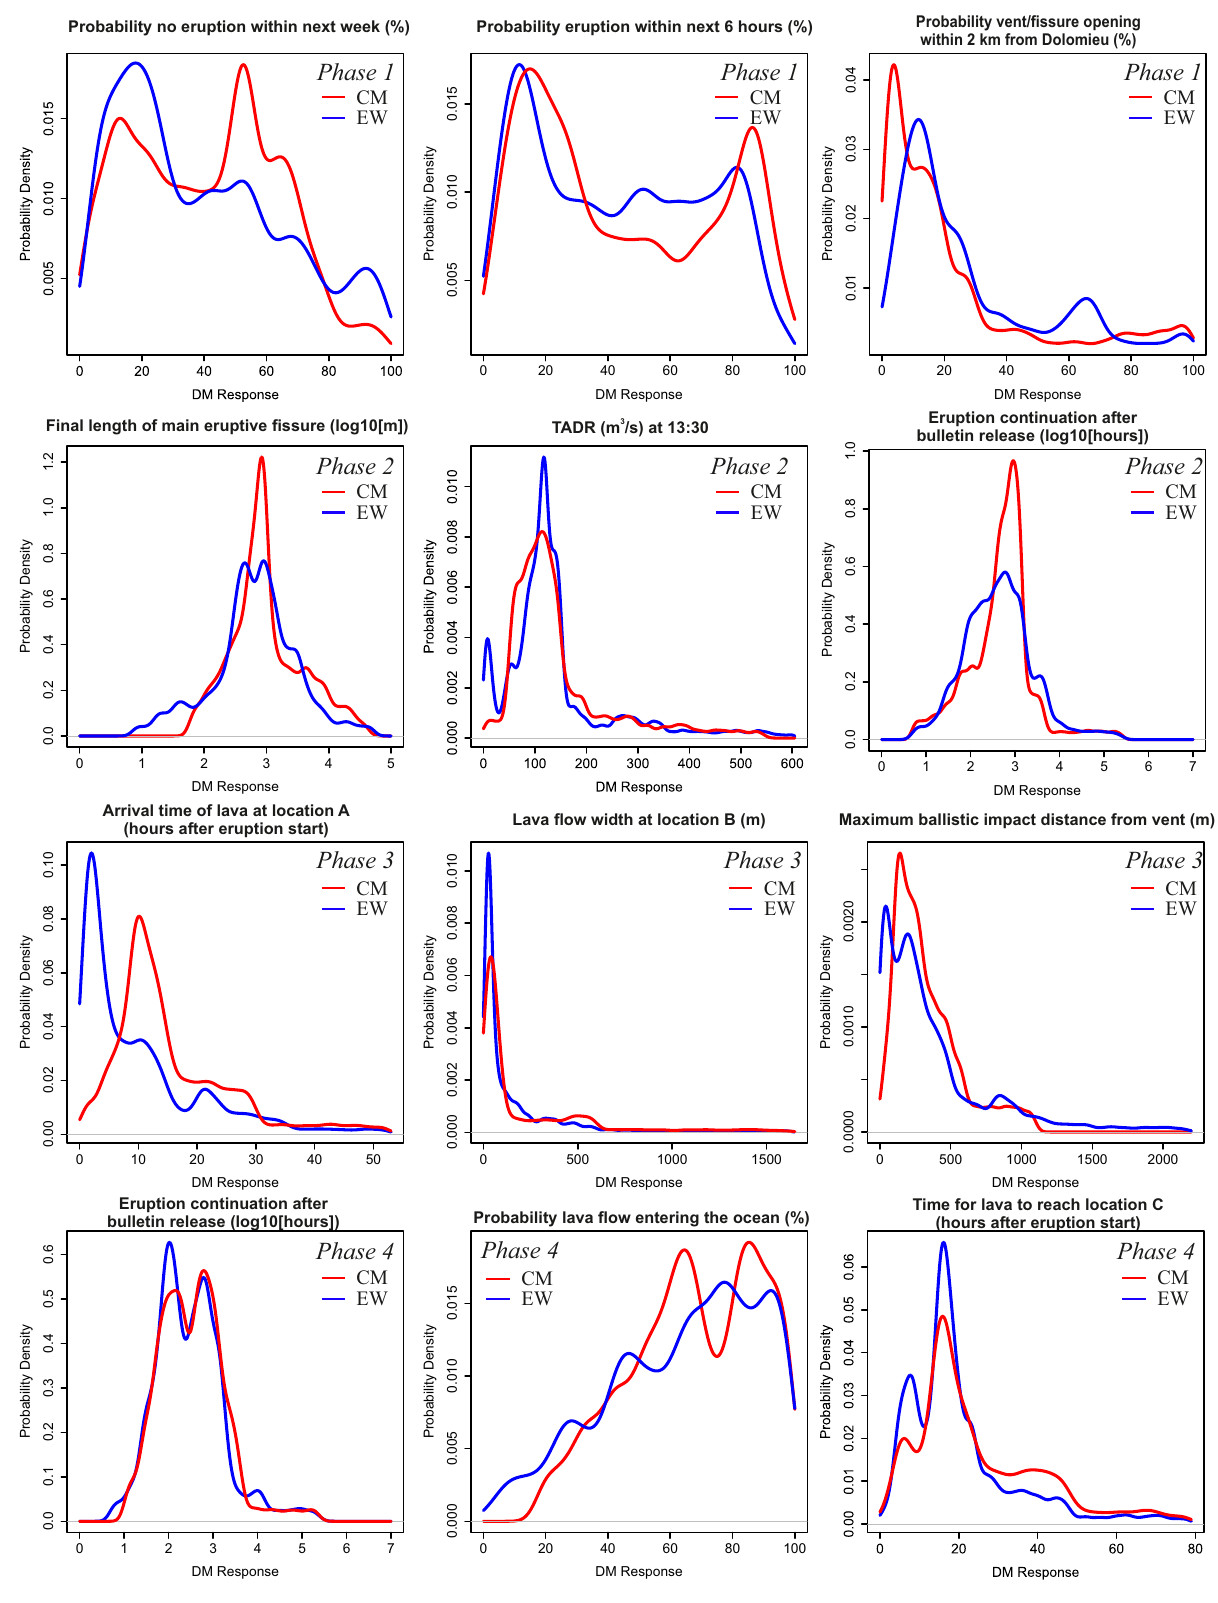
Figure 5: Probability density functions for the decision maker (DM) obtained with the Classical Model (CM—red lines) and Equal Weight (EW—blue lines) pooling methods. For Q1 & Q3 in Phase 2 and Q1 in Phase 4, the x axis is a logarithmic